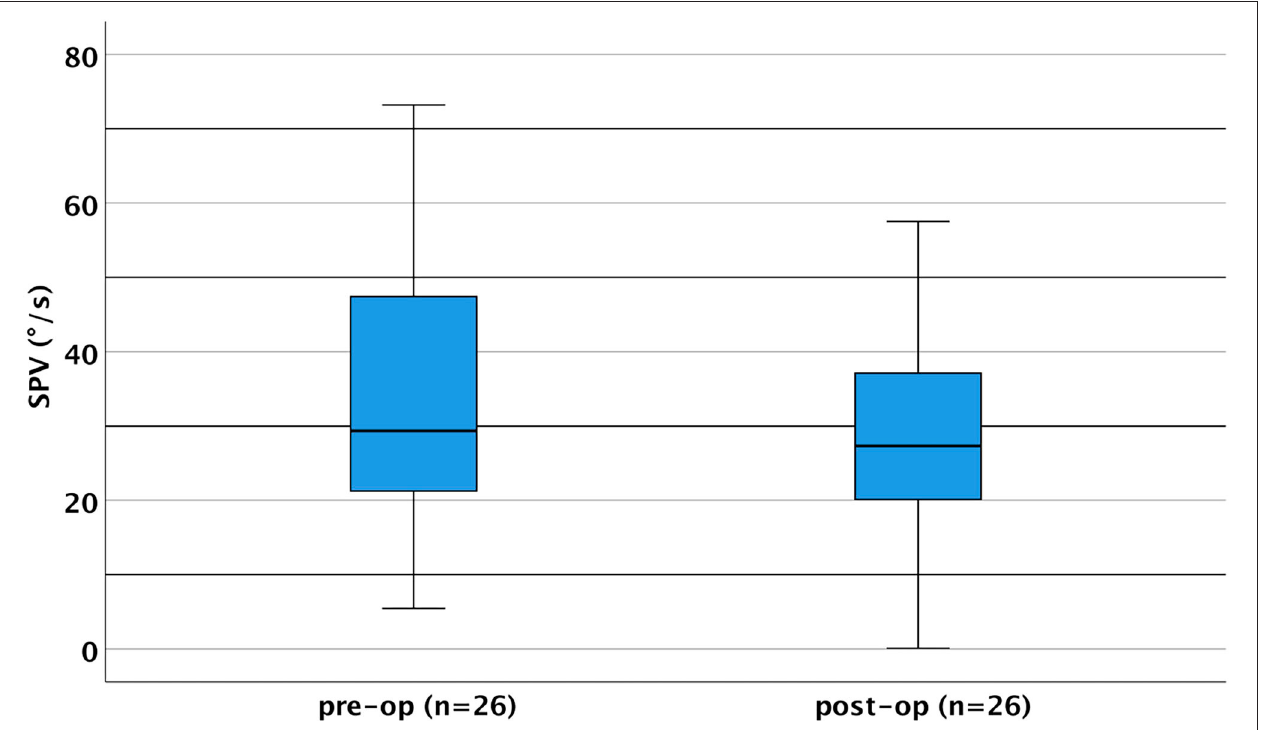
FIGURE 2 | Caloric slow-phase velocity (SPV; sum of cold and warm irrigation) pre- and post-operatively of the implanted side (boxplots). SPV ranged preoperatively from 5.44 ◦ /s up to 73.19 ◦ /s (mean = 32.78 ± 18.50 ◦ /s) and postoperatively from 0.1 ◦ /s up to 57.53 ◦ /s (mean = 28.74 ± 15.41 ◦ /s). SPV was approximately normally distributed for both intervals as assessed by the Shapiro–Wilk test (preoperatively, p = 0.242; postoperatively, p = 0.565).